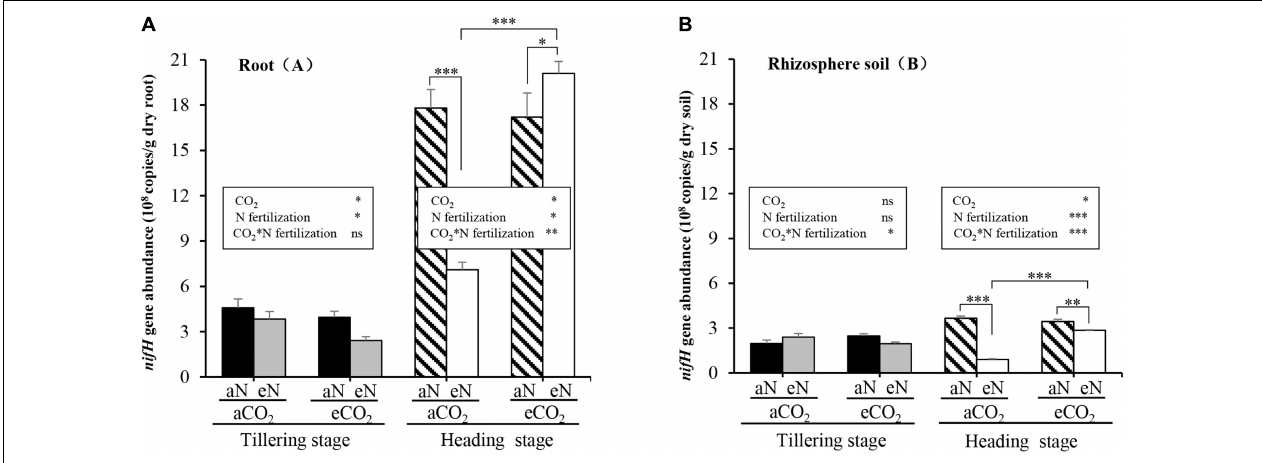
FIGURE 2 | Interactive effects of elevated CO 2 and N fertilization on nifH abundance in roots (A) and rhizosphere soils (B) of rice grown in the paddy field at the tillering (TI) and heading (HI) stages. aCO 2 , ambient CO 2 ; eCO 2 , elevated atmospheric CO 2 . aN, no N fertilization; eN, elevated N fertilization. Considering the split-plot design, the statistics were derived using linear mixed-effects model procedure to test the effect of elevated CO 2 , N fertilization, and their interactions on nifH copy numbers at the same growth stage. Multiple comparison were further used to determine which groups were significantly different with Duncan test. The comparison of nifH copy numbers at the tillering and heading stages from the same plot with paired samples t -test (Data were showed in Supplementary Table 2 ). ∗∗∗ p ≤ 0.001, ∗∗ p ≤ 0.01, ∗ p ≤ 0.05, ns p > 0.10.